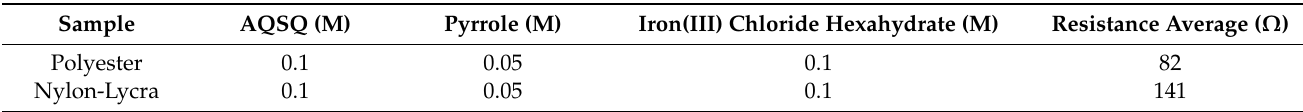
Table 2. Optimized synthesis parameters